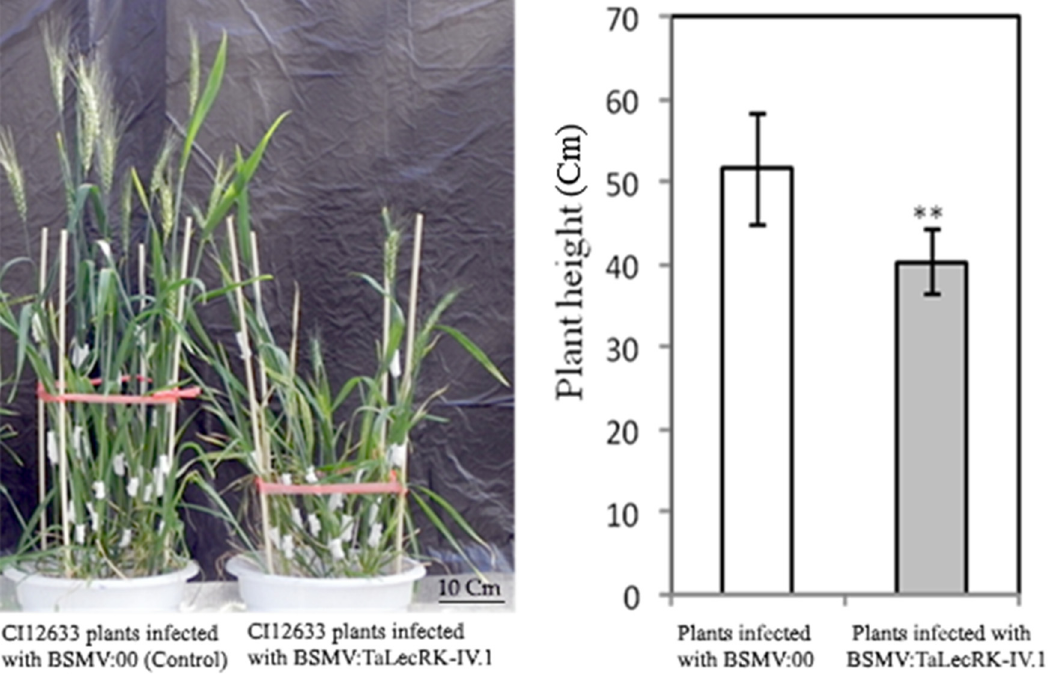
Figure 3. Phenotypes ( left ) and average heights ( right ) of the wheat CI12633 plants subjected to TaLecRK-IV.1 -silencing experiment. CI12633 plants were inoculated either with empty BSMV vec- tor ( γ :00) and used as control or infected with BSMV vector carrying a fragment of TaLecRK-IV.1 ( γ :TaLecRK-IV.1) for the gene-silencing purpose. The test of comparison for the average plant height results from the Student’s t -test (double asterisks indicate significant difference at 0.01 probabil- ity